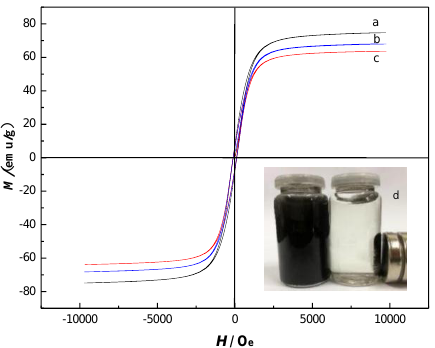
Figure 4. The magnetization curves of ( a ) Fe 3 O 4 ; ( b ) Fe 3 O 4 @mSiO 2 ; ( c ) Fe 3 O 4 @mSiO 2